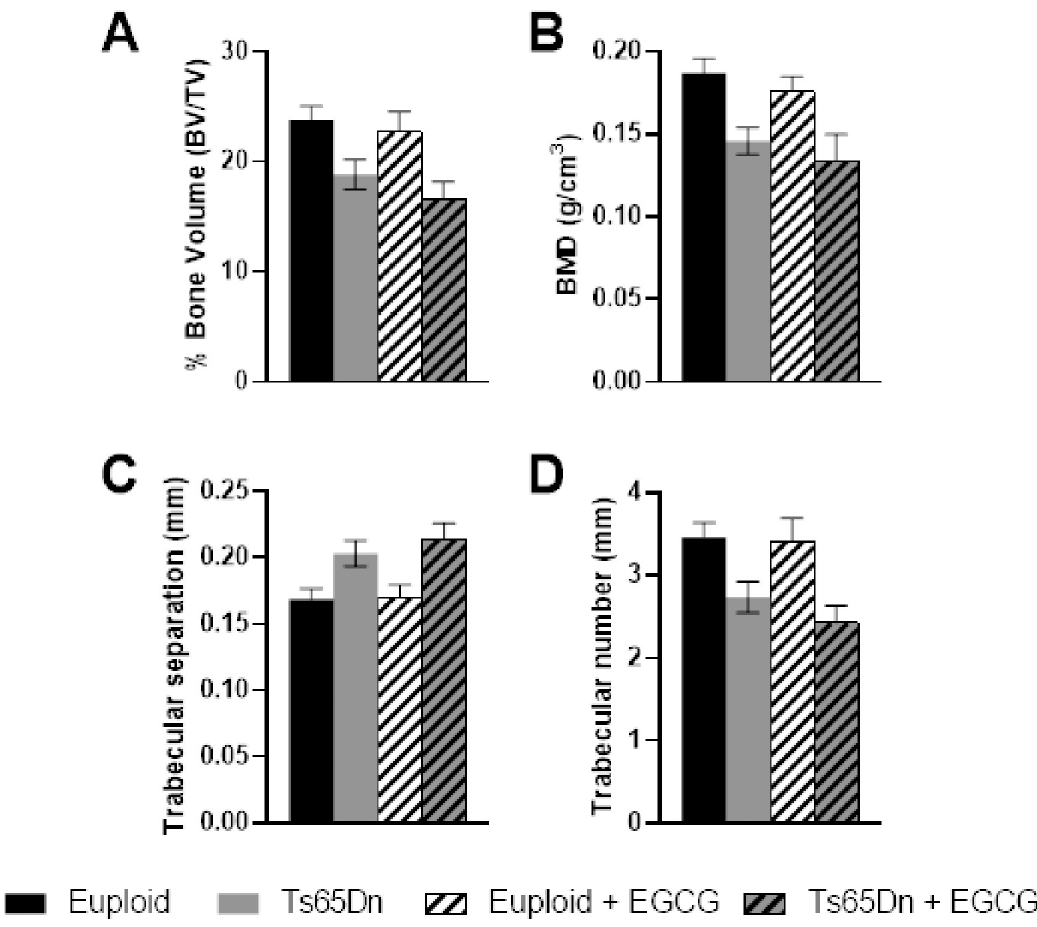
Fig 1. Trabecular bone measurements from Ts65Dn and Euploid mice treated with EGCG or control fluid. A. Percent bone volume. B. Bone mineral density (BMD). C. Trabecular separation (Tb.Sp). D. Trabecular number (Tb.N). Numbers indicated are average measurements ± standard error of the mean (SEM). No differences were detected between groups in post hoc analyses. For numbers of animals and ANOVA results, please see Table